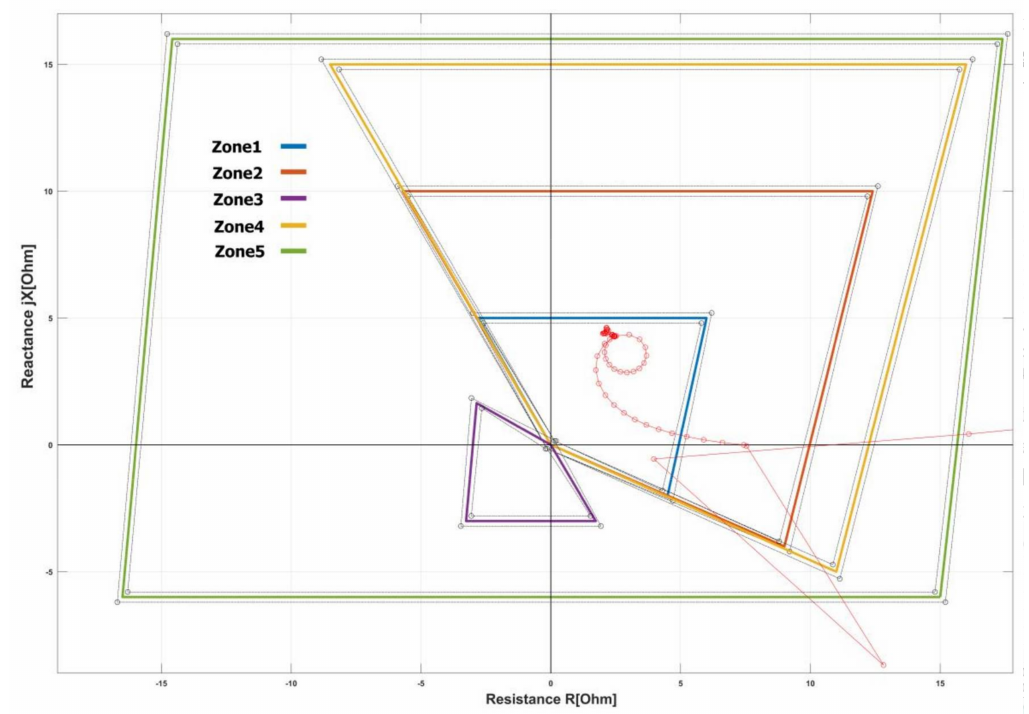
Figure 7. Characteristic zones of a distance relay and fault